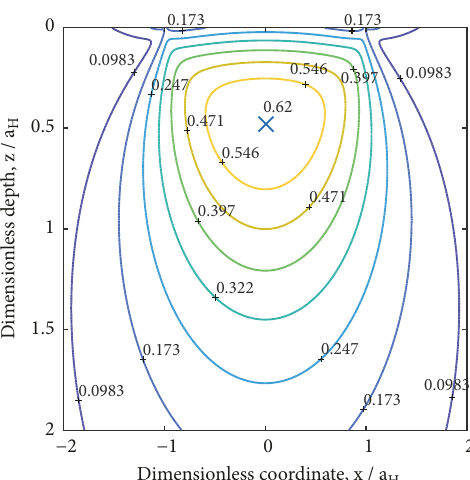
Figure11:Iso-contoursofdimensionlessvonMisesequivalentstress 𝜎 /𝑝 𝑦 = 0 ; 𝐸 = 𝐸 𝑉𝑀 𝐻 in the plane 1 2 .